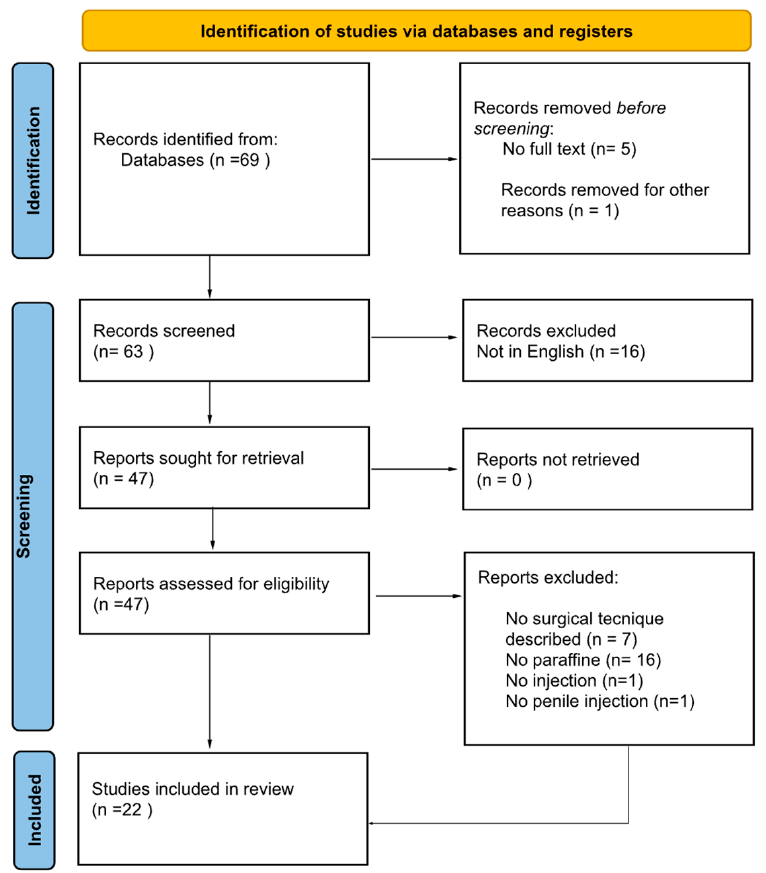
Figure 9. PRISMA statement.